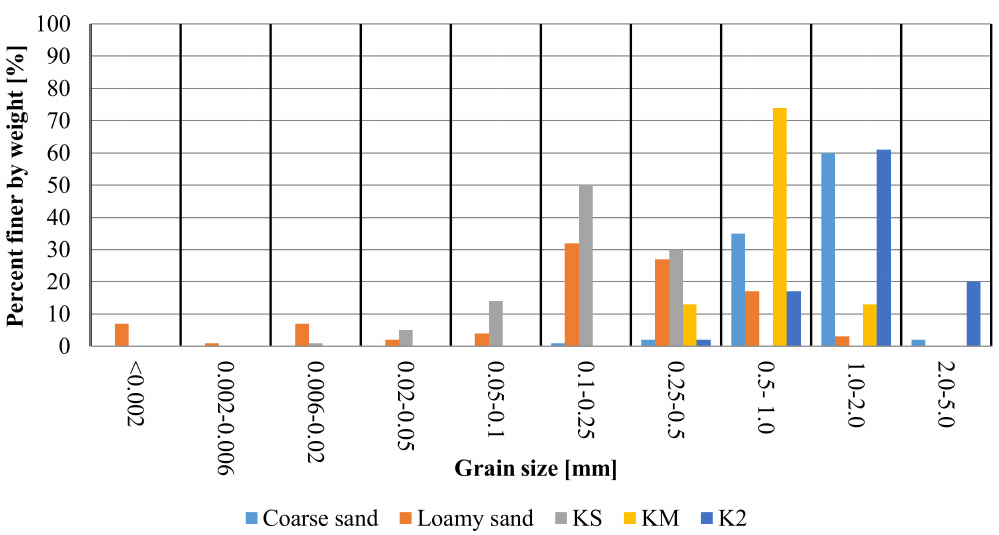
Figure 4. Grain size distributions of the tested SAP and